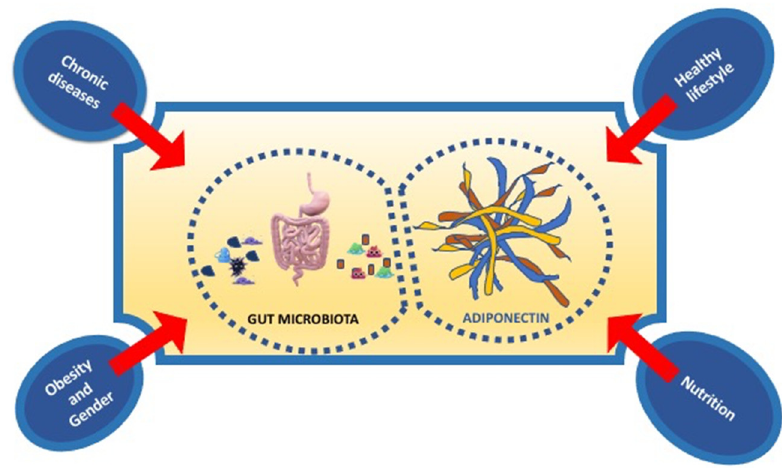
Figure 3. The principal factors influencing the interplay between gut microbiota and adiponectin.